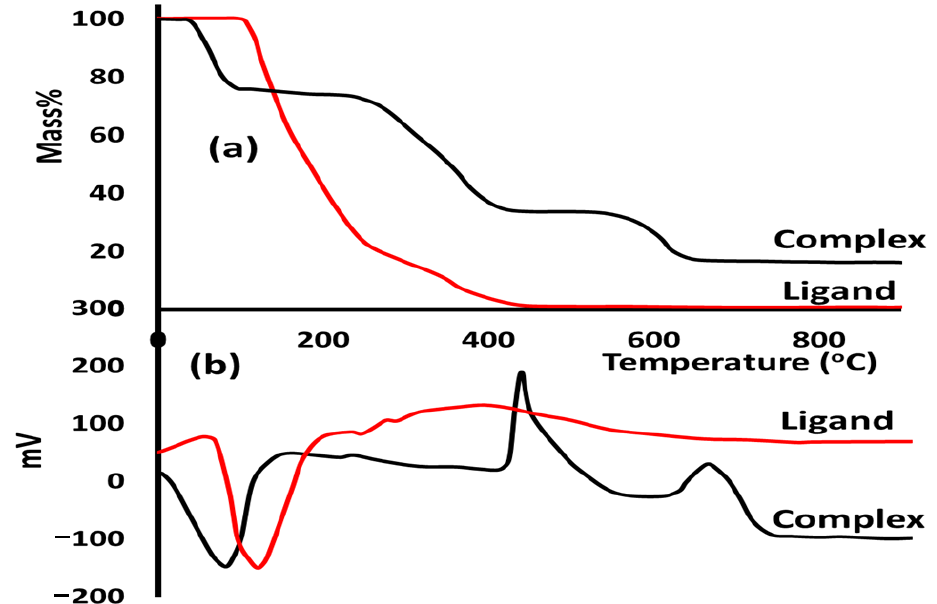
Figure 3. ( a ) TG and ( b ) DTA curves of the free ligand and its